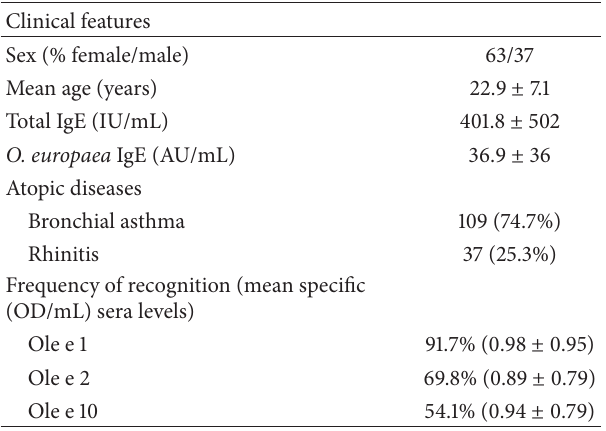
Table 2: Clinical features of the olive pollen allergic